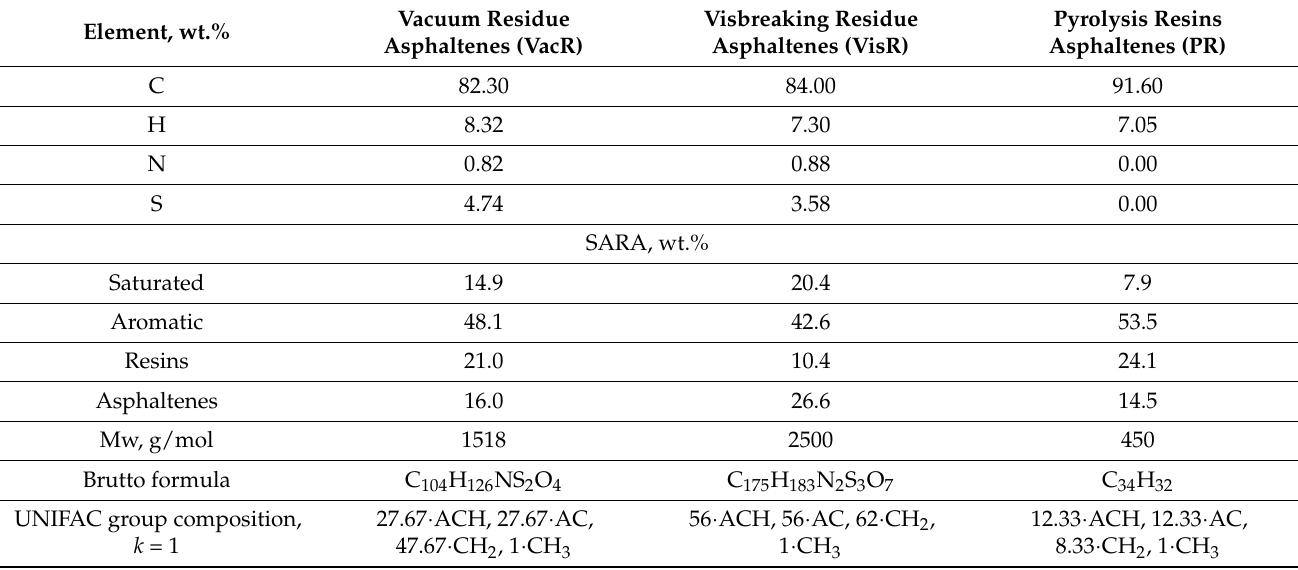
Table 2. Elemental and group composition of asphaltenes used in